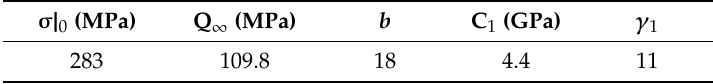
Table 1. Parameters for the nonlinear isotropic / kinematic hardening